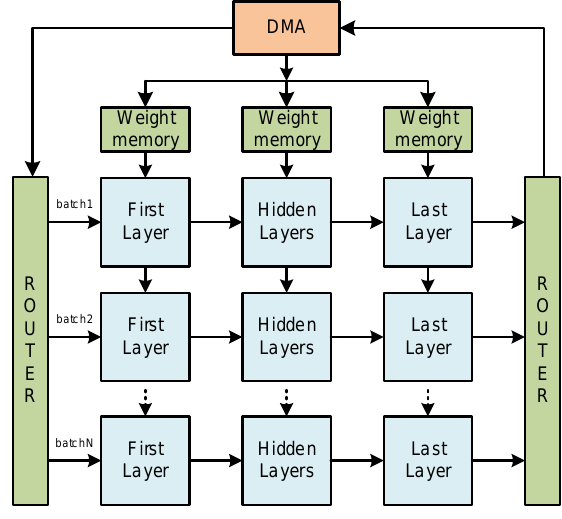
Figure 4. Architecture with a batch